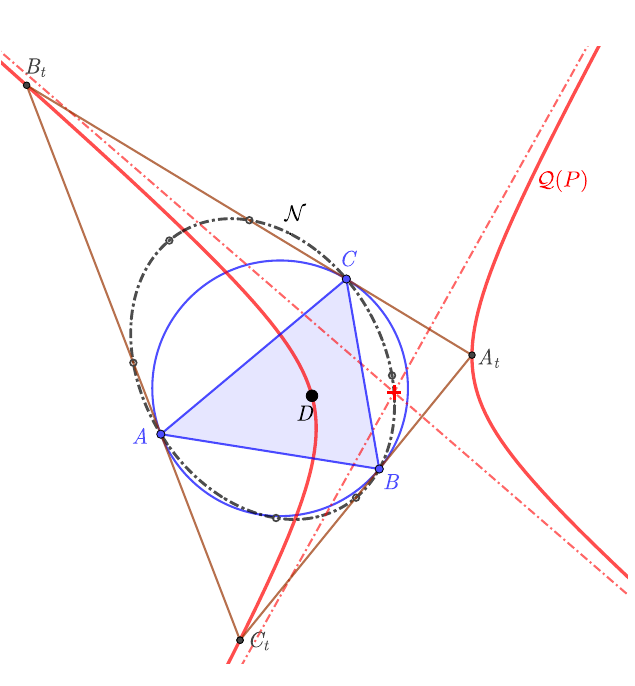
Figure 9. Nine-point